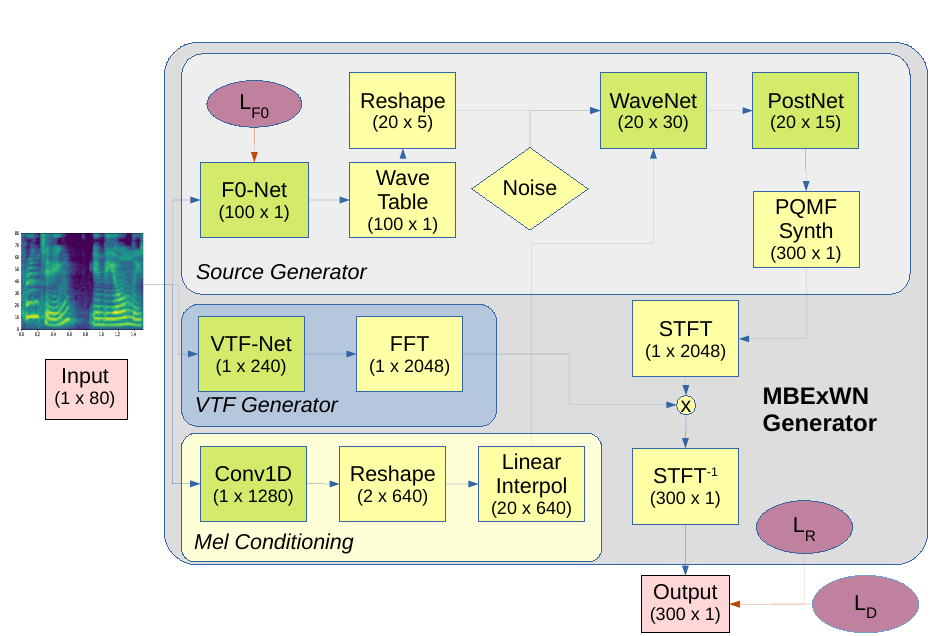
Figure 1. MBExWN schematic generator: Green boxes are DNN models, yellow boxes are differ- entiable DSP operators, red ovals are losses. The numbers below the boxes designate the output dimension of the respective box in the format time × channels (batch dimension not shown) for a sin- gle mel frame as input (dimensions 1 × 80). In the present study, the mel frame hop size is 300 samples @ 24 kHz and therefore the model needs to achieve an overall upsampling factor of